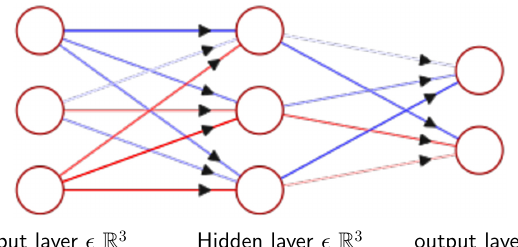
FIG. 4. The implementation of FCNN used in numerical sim- ulations.